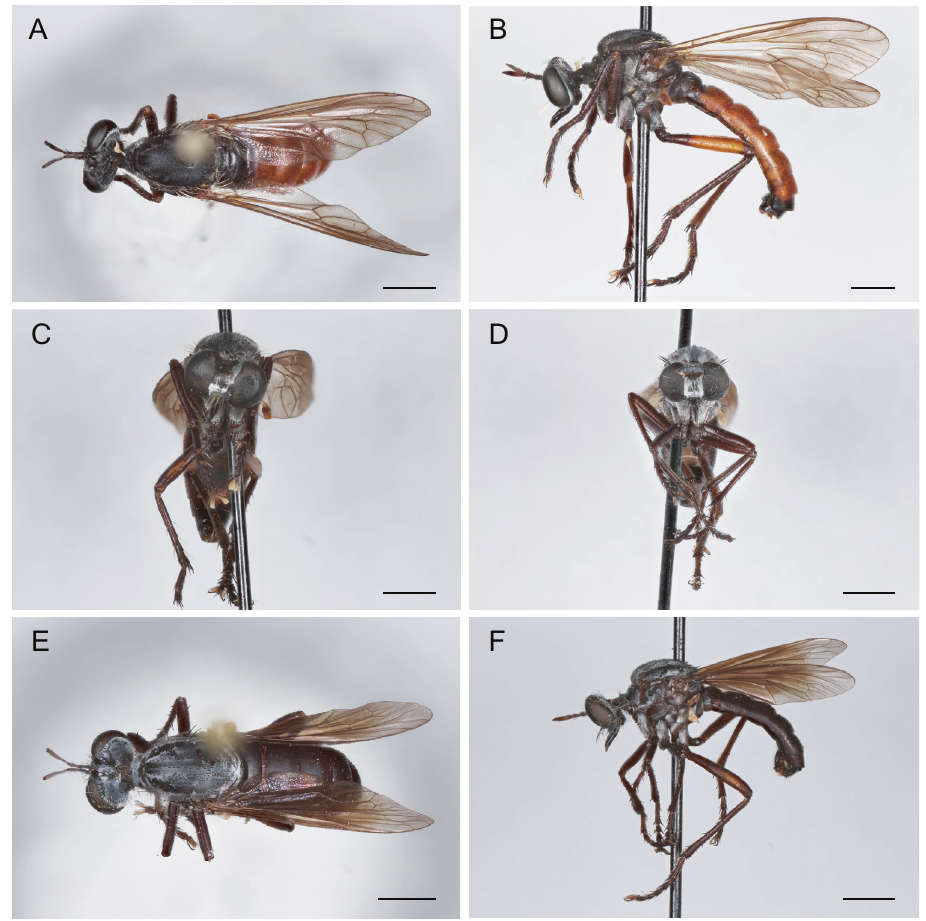
Figure 29. Saropogon senex Osten Sacken, 1887 Female (UCBMEP0280483): A dorsal view B lateral view C anterior view; Male (UCBMEP0280489): D anterior view E dorsal view F lateral view. Scale bars: 2